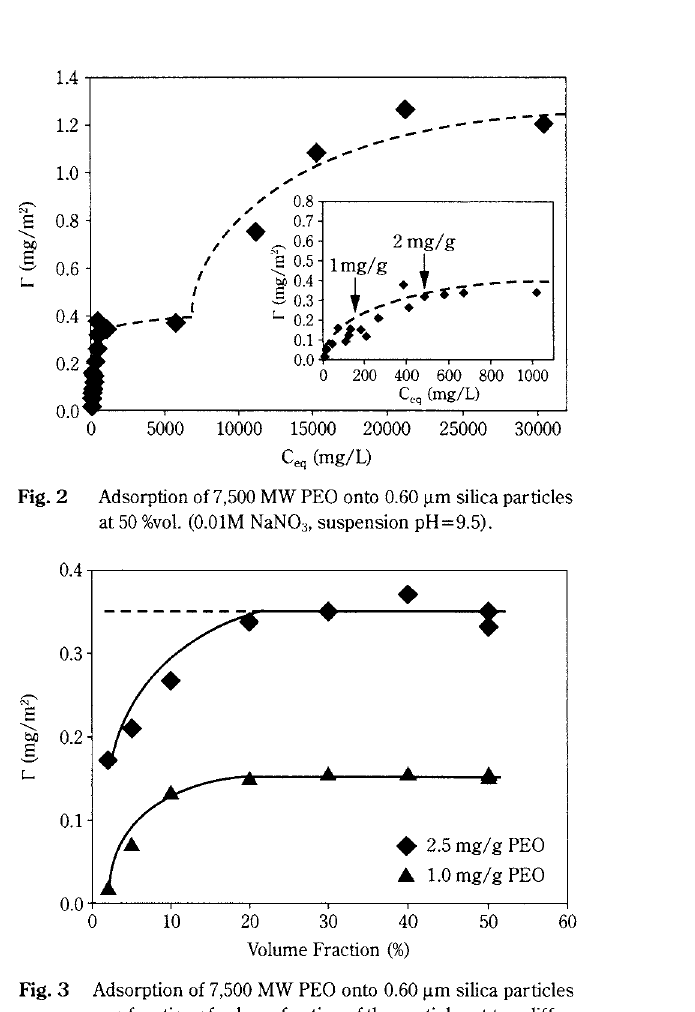
Fig. 3 Adsorption of 7,500 MW PEO onto 0.60 ).l.m silica particles as a function of volume fraction of the particles at two differ ent polymer dosages. (0.01M NaN0 3, suspension pH=9.5). 0.6,----------------~